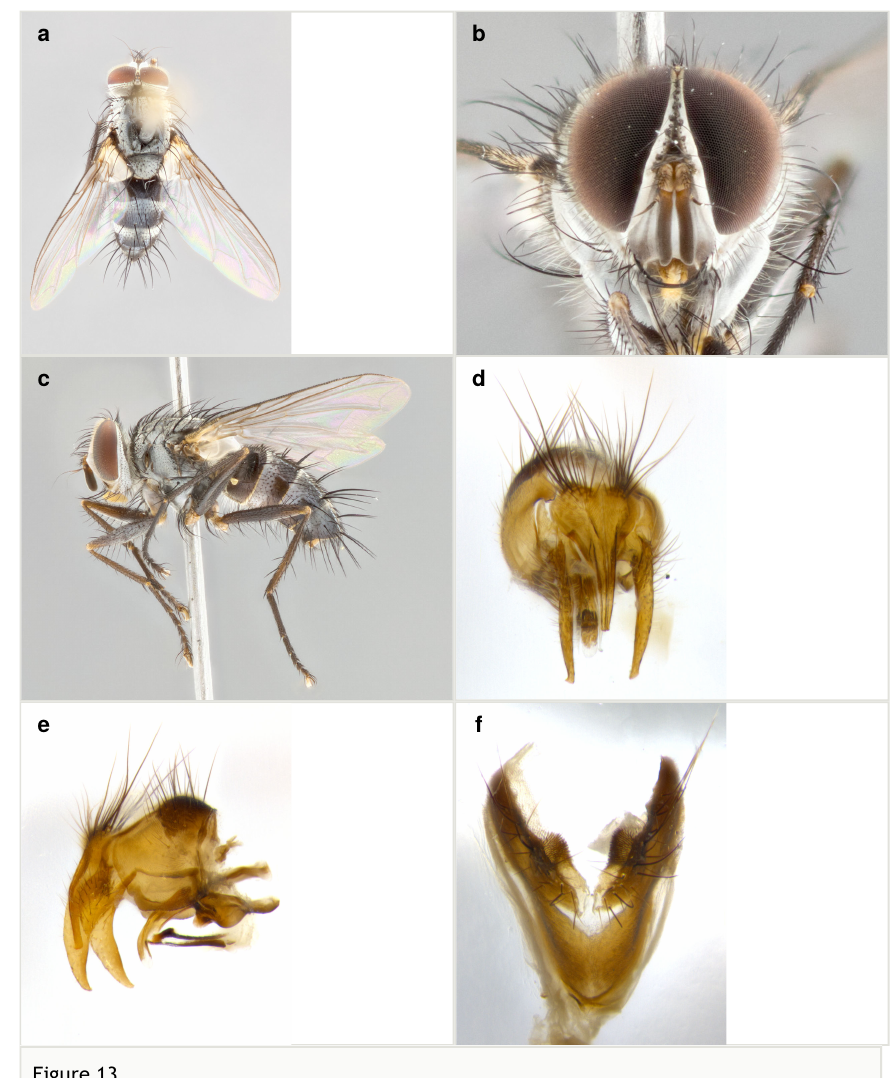
Figure 13. Uramya nitida sp. nov. ; a-c : holotype male; voucher n. DHJPAR0029599; d-f : paratype male; voucher n.